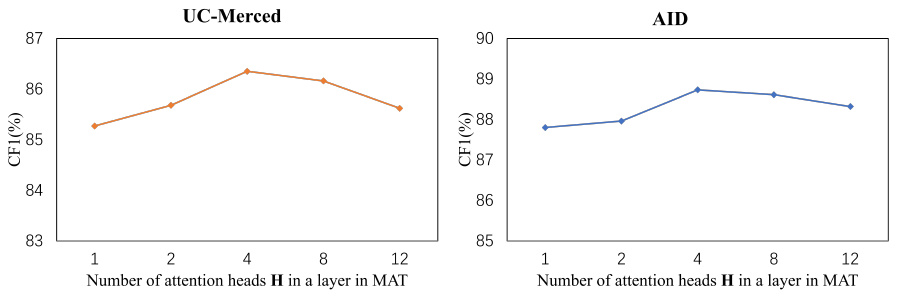
Figure 4. The results of the ablation studies on the number of attention heads in a layer in